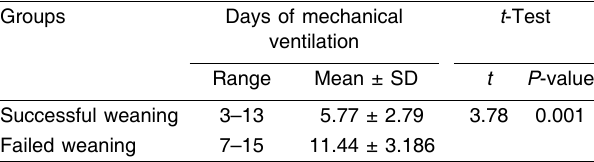
Table 4 Comparison between groups with successful weaning and those with failed weaning as regards days of mechanical ventilation Groups